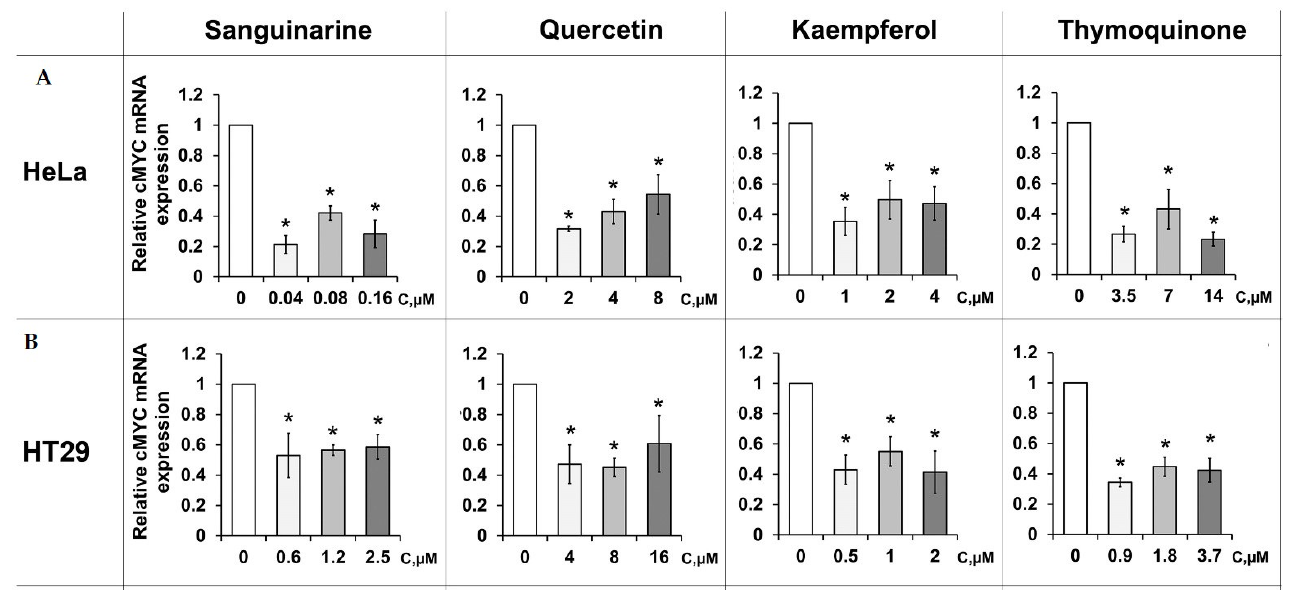
Figure 4. Effects of PSMs on c-MYC -controlled expression in HeLa ( A ) and HT29 ( B ) cells as assessed by luciferase reporter assay. All data are presented as M ± m. * Differences are statistically significant compared to control ( p <